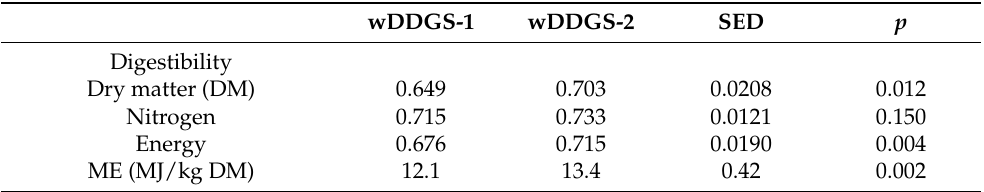
Table A3. Methane output by sheep fed on diets consisting of hay plus wDDGS-1 or wDDGS-2. wDDGS-1 wDDGS-2 SED p Methane, g/day 14.9 10.1 0.46 <0.001 Methane, g/kg DMI 10.7 7.22 0.33 <0.001 Methane, % GEI 3.01 2.17 0.094